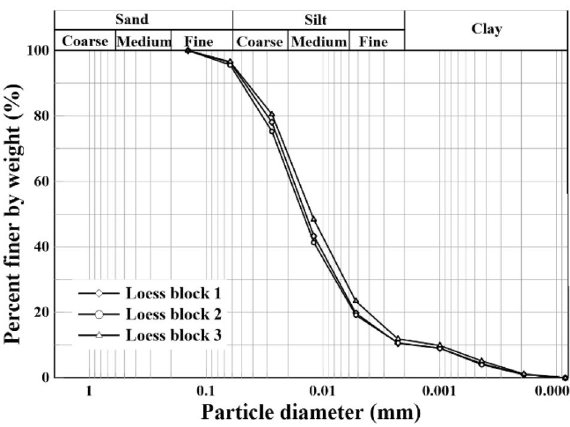
Figure 1. Particle-size distribution curves for the natural loess.